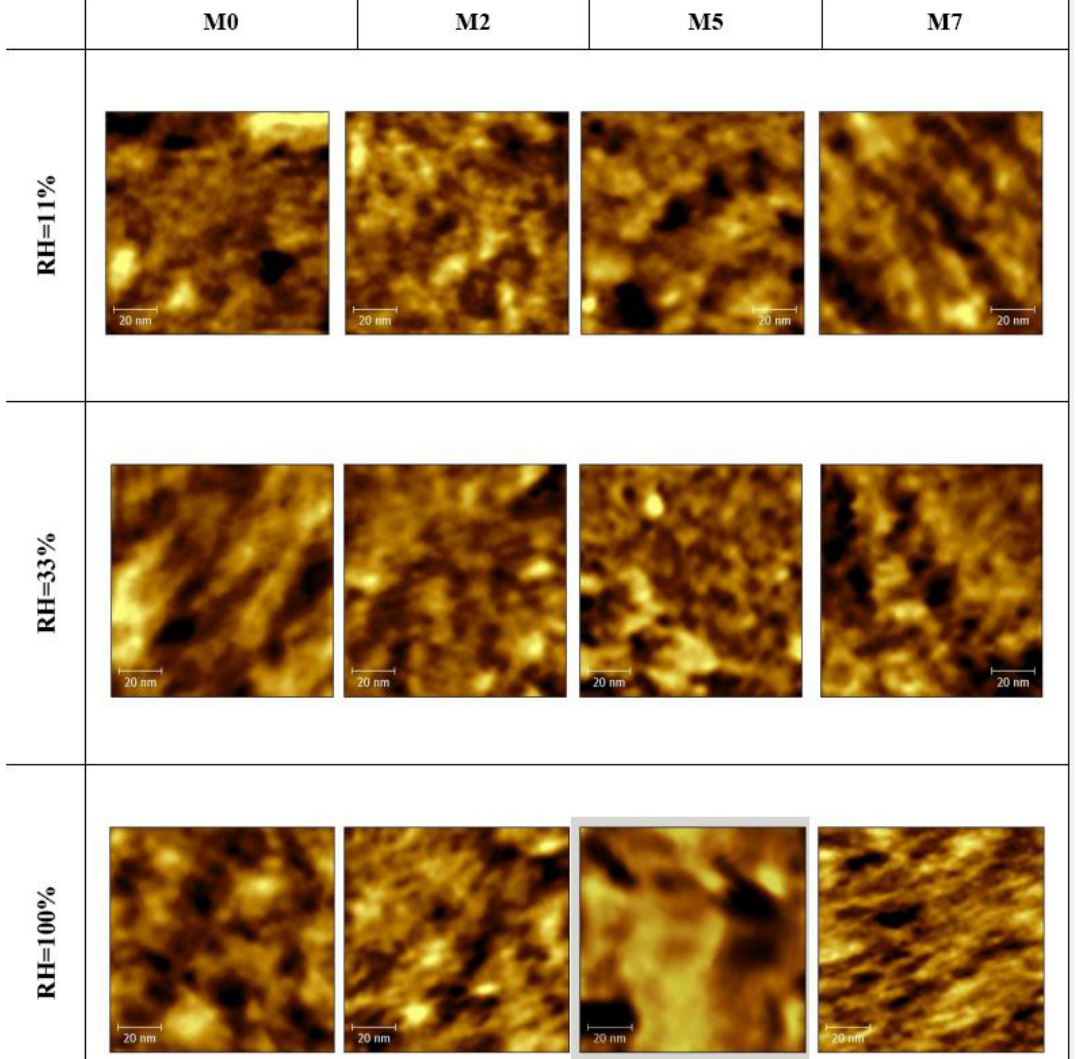
Figure 3. Atomic force microscopies (AFM) for the four membranes in three different RH conditions.